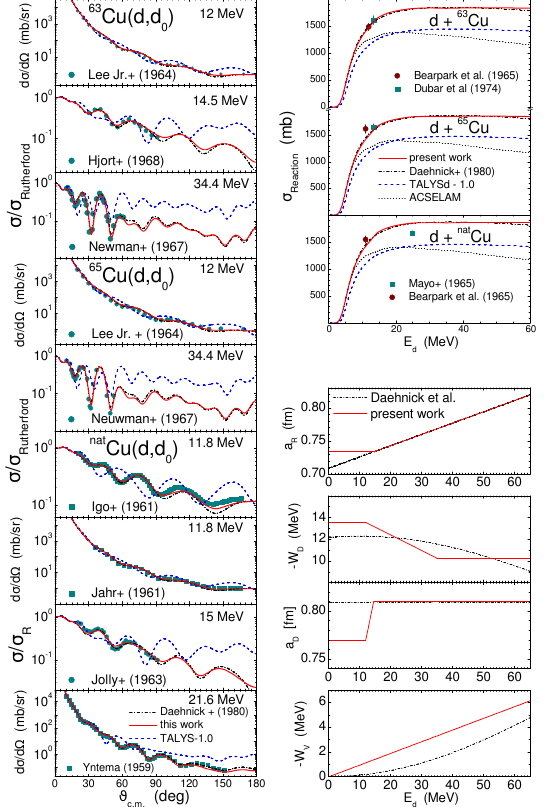
Fig. 1. (Color online) Optical model potential analysis of the deuterons interaction with 63 , 65 , nat Cu (see details in the text).